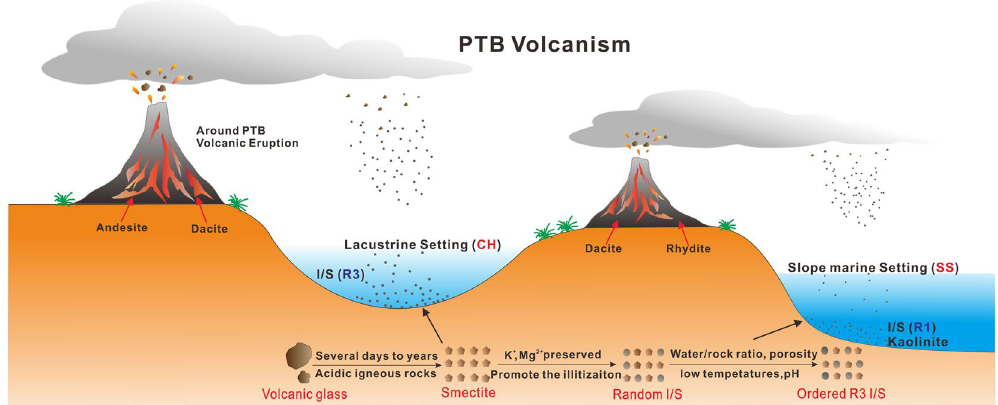
Figure 8. The evolution from the volcanic ashes to the I-S layer mineral in marine and terrestrial sedimentary environment in